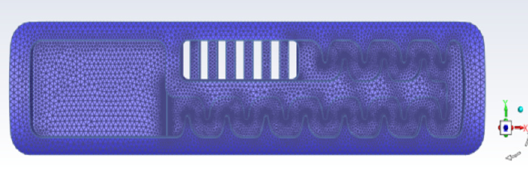
Figure 8. The face meshing of the fluid space.